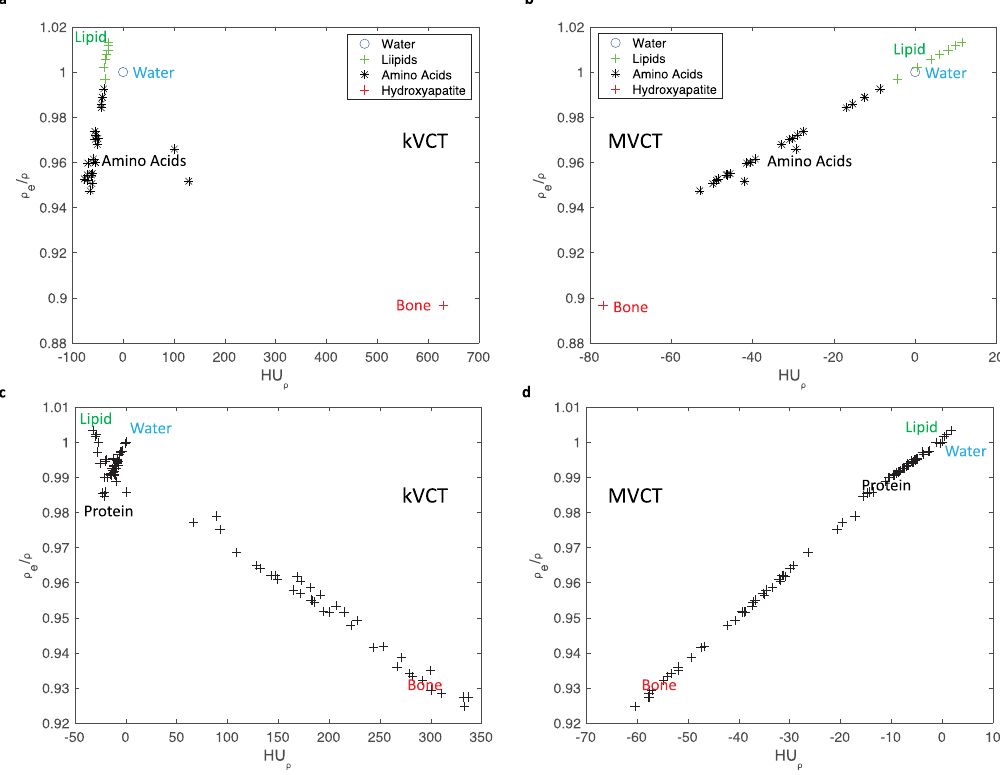
Fig 1. Calculated mass density normalized HU, HU ρ , were plotted against mass density normalized electron density, ρ For biologically relevant molecules (A) kVCT and (B) MVCT energies. For human tissues at (C) kVCT and (D) MVCT. Molecule types are indicated by symbols, colors, and with labels in panels A and B. For panels C and D, tissue types contained a wide range of molecules although trends towards higher lipid, water, and protein content are labelled with text in the figure.